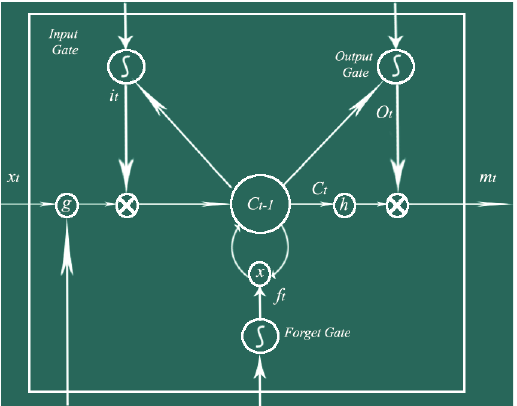
Figure 10. Architecture of a LSTM Memory Unit in Hidden